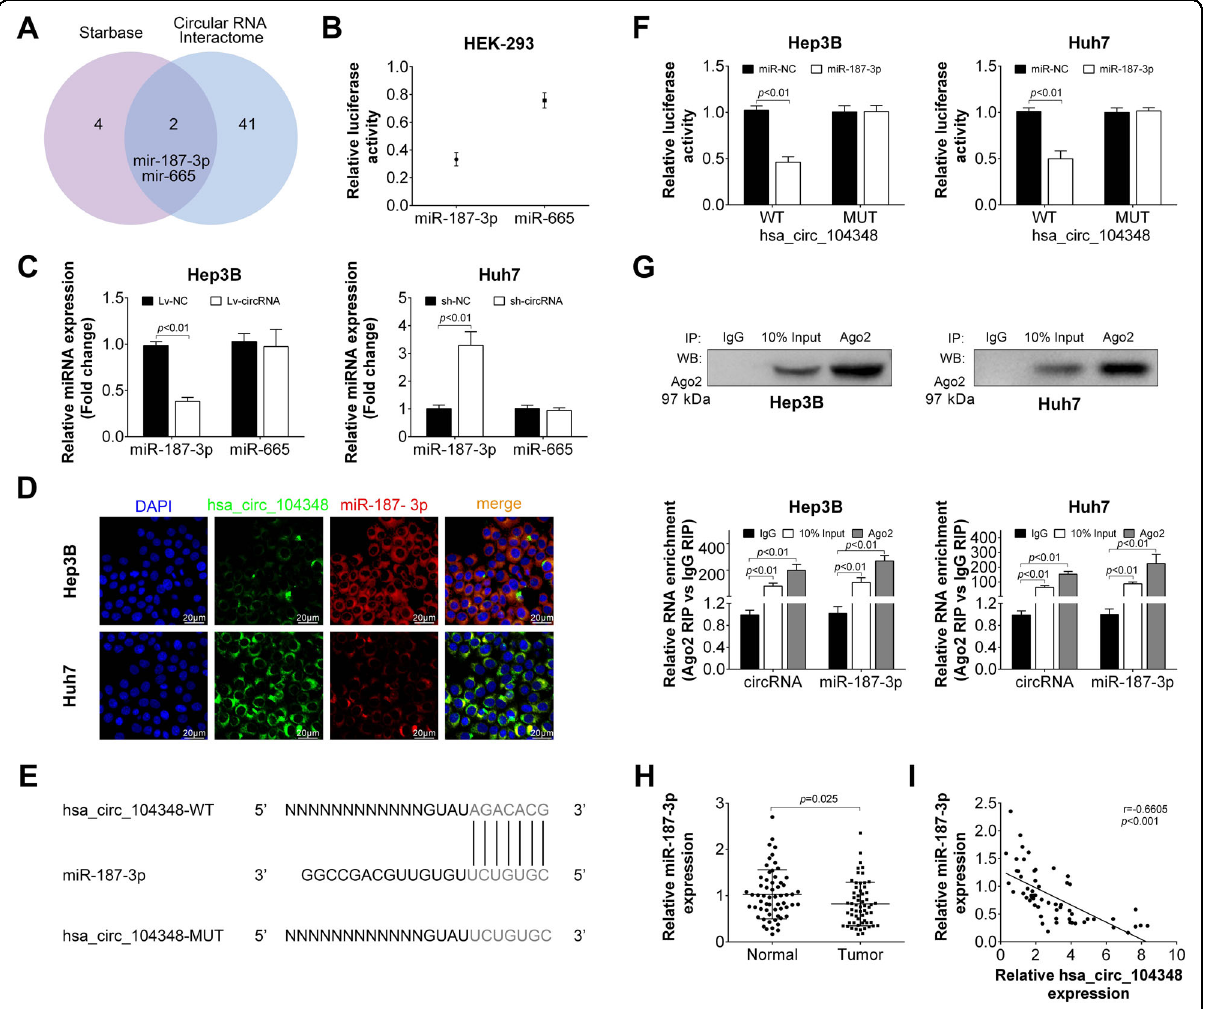
Fig. 4 The expression of has_circ_104348 was negatively correlated with the expression of miR-187- 3p. A Overlap region showed the predicted miRNAs from Starbas and Circular RNA Interactome. B Relative luciferase activity of miR-187-3p and miR-665 was detected by dual- luciferase reporter assay. C The expression of miR-187-3p and miR-665 was determined in has_circ_104348 overexpression or knockdown system. D The location of has_circ_104348 and miR-187-3p were detected by FISH. The scale bars were 20 μ m. E The potential binding site of has_circ_104348 and miR-187-3p. F Dual-luciferase reporter assay was performed to con fi rm the binding site of has_circ_104348 and miR-187-3p. G RIP assay was used to test the combination of has_circ_104348 and miR-187-3p. H The expression of miR-187-3p was determined in tumor or paired normal tissues by qRT-PCR. I The correlation analysis between has_circ_104348 and miR-187-3p. Data were expressed as mean ±